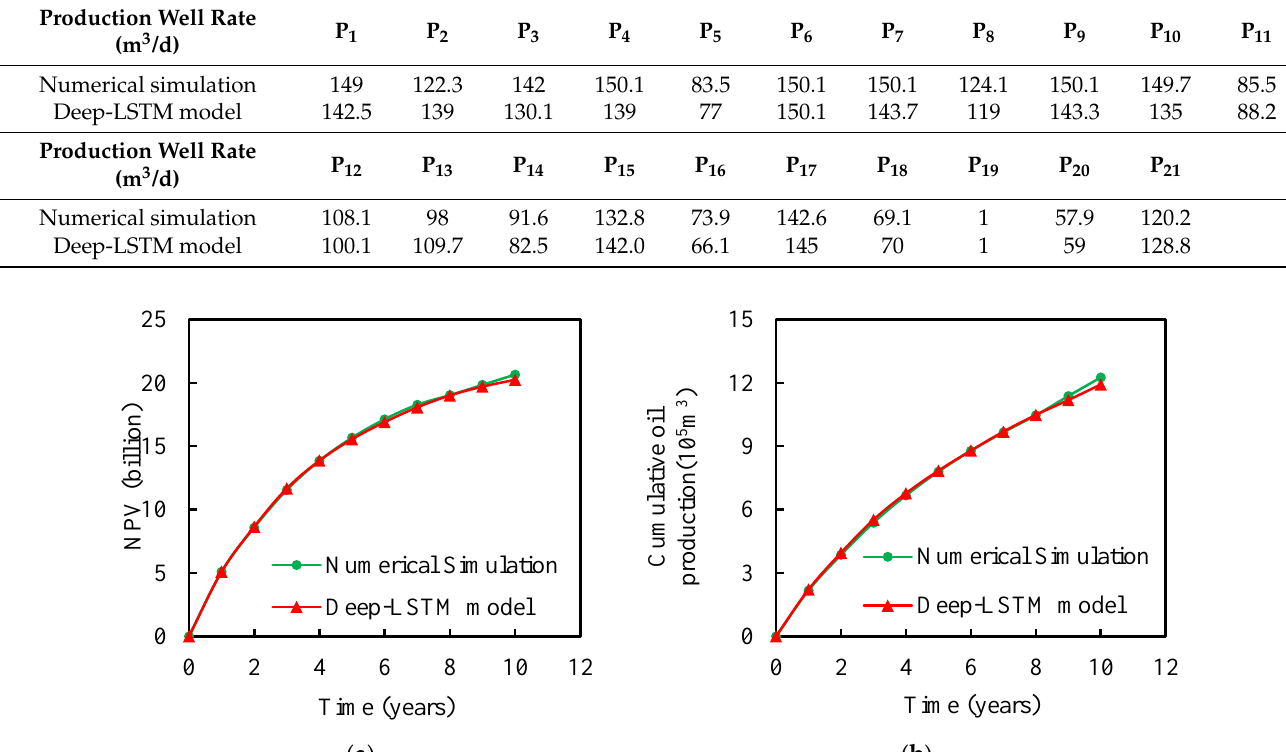
Figure 10. Comparison of ( a ) NPV and ( b ) cumulative oil production using different methods.